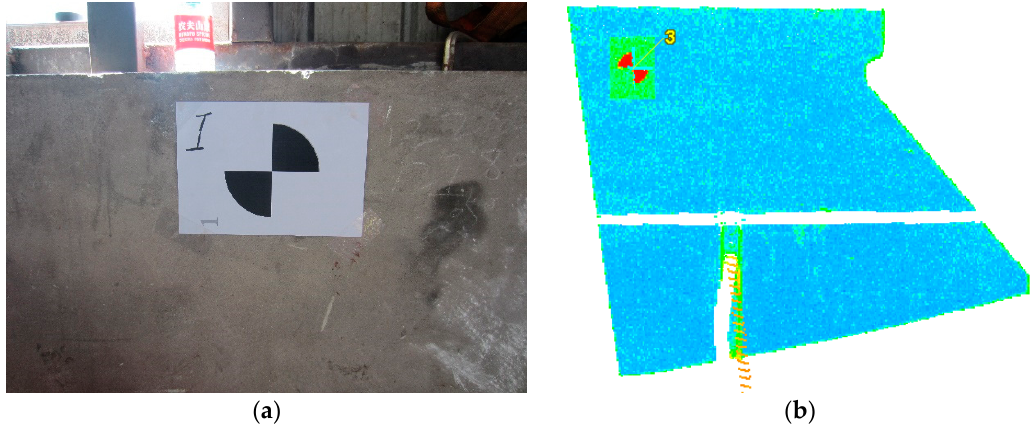
Figure 2. Sample targets used for establishing the global coordinate system: ( a ) picture of a target used on site; and ( b ) an image of the point cloud of targets.